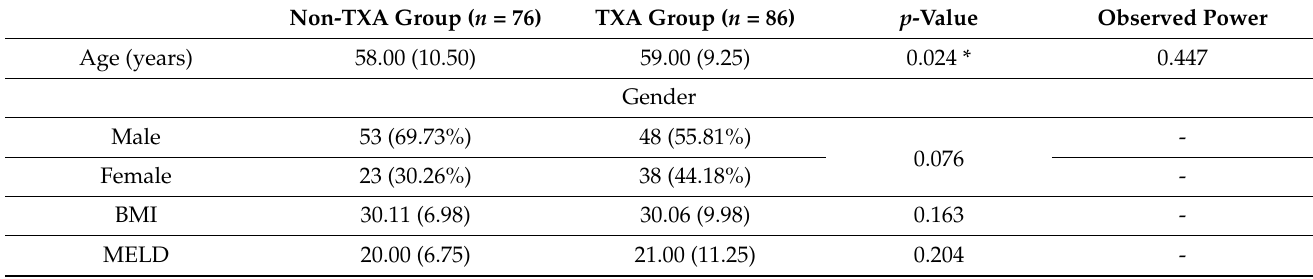
Table 1. Baseline characteristics of LT patients categorised by intraoperative treatment of